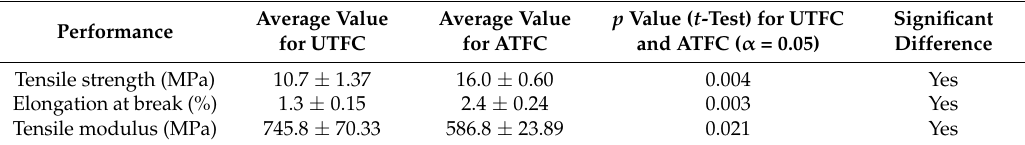
Table 2. Mechanical properties of composites.